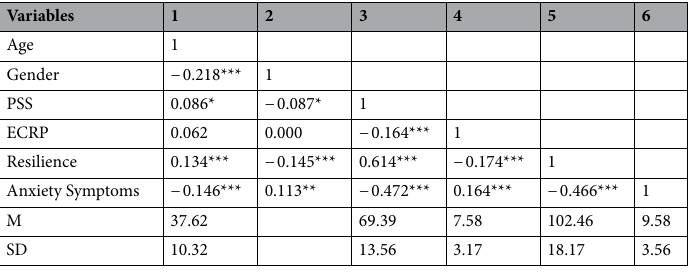
Table 1. Results of correlation analysis. Gender, 1 = male, 0 = female, * P < 0.05, *** P < 0.01, *** P < 0.001.